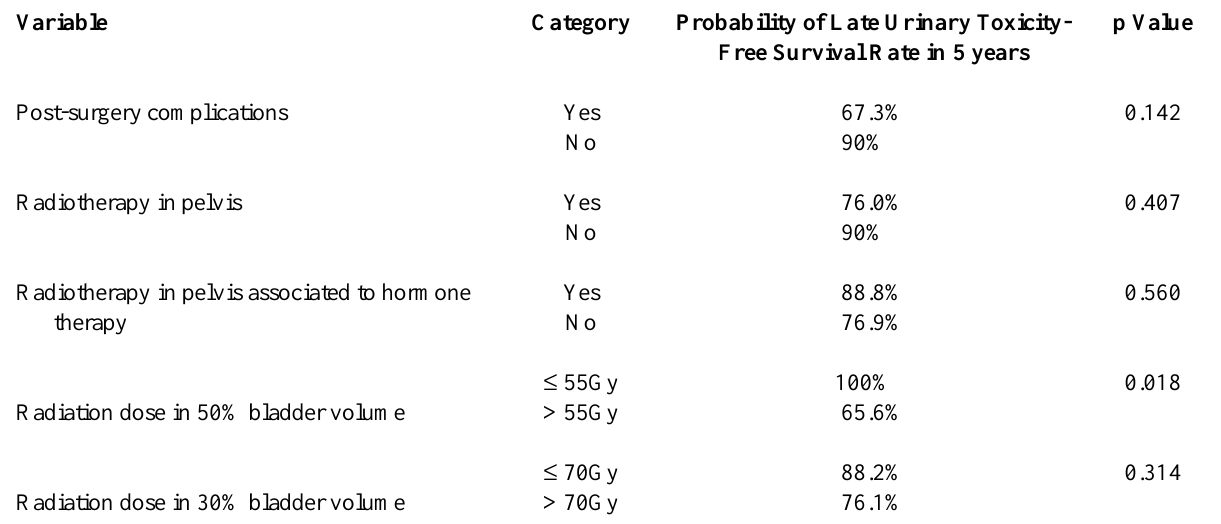
Table 5 – Univariate analysis of variables associated to late urinary toxicity-free survival rate grades 2 and 3 after survival conformal radiotherapy in 5